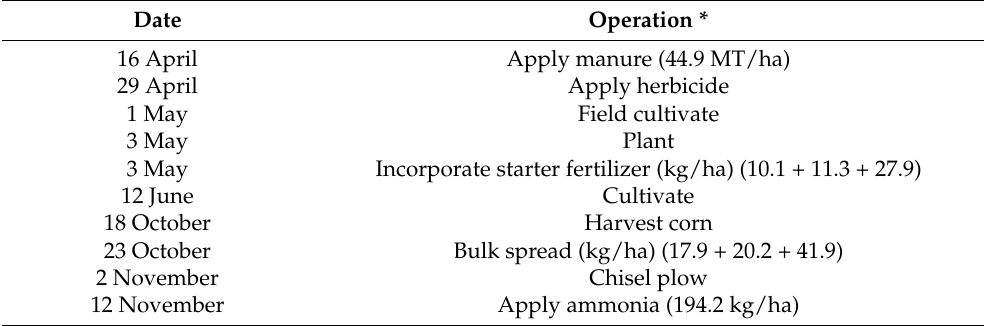
Table 1. Field operations simulated for continuous corn for 1998–2000 production